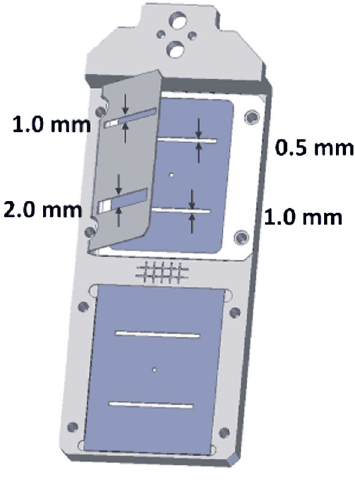
FIG. 7. Sketch of the screen setup.